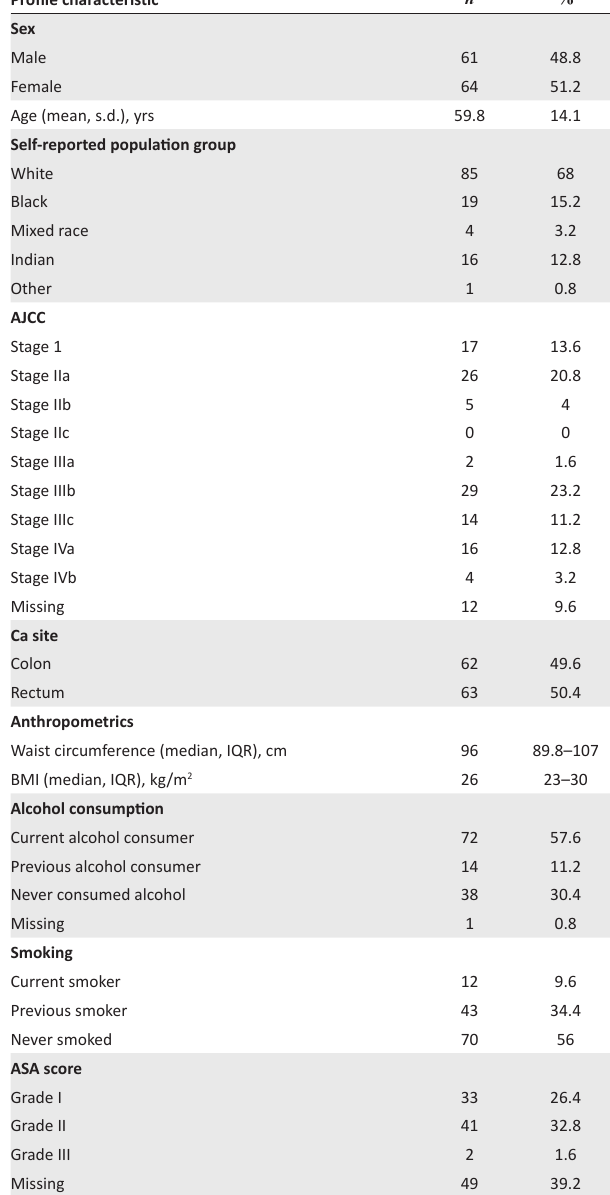
TABLE 1: Demographic and clinical profile of South African urban cohort presenting with colorectal Ca at a large private university specialist referral centre ( n =